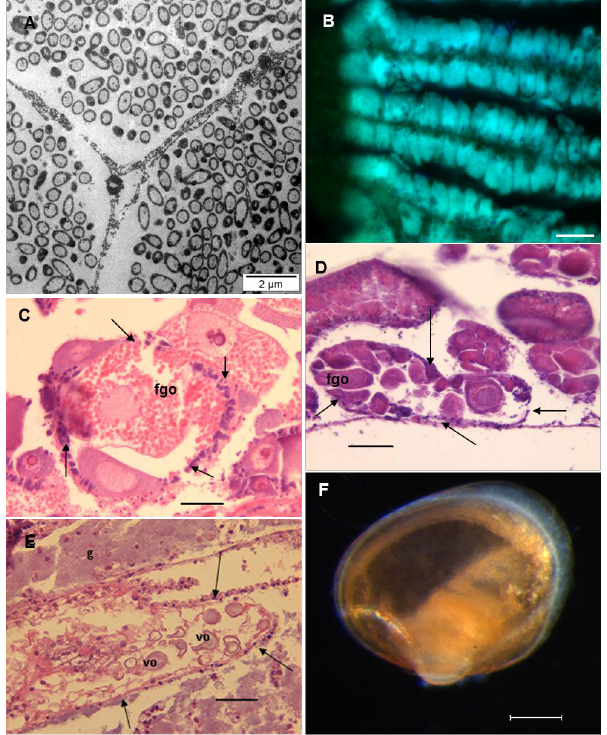
Figure 3: Fig. 3. (A) Detail of sulfur-oxidizing symbionts associated with gill filaments of Thyasira sp. Regab (Thyasiridae) under the TEM. (B) Fluorescence in situ hybridization using a symbiont-specific probe on a cross section through 3 gill filaments of Myrtea spinifera (Lucinidae) showing the dense populations of bacteria in the lat- eral zone. Scale bar=50µm. (C–E) Histological sections of fe- male gonads stained with hematoxylin-eosin. Scales bars are 50µm. (C) Detail of an acinus (arrows delimiting) encompassing a large lecithotrophic oocyte (fgo: fully grown oocytes of ∼ 150µm diam- eter) in Isorropodon bigoti (Vesicomyidae). (D) Detail of an acinus (arrows delimiting) encompassing smaller fully grown oocytes (fgo; ∼ 60µm diameter) in Idas modiolaeformis (Mytilidae) that has a planktotrophic larvae. (E) Detail of a gonad (arrows delimiting) en- compassing small vitellogenic oocytes (vo) ∼ 20 to 30µm diameter in Thyasira sp. nov. from the Guiness site (Thyasiridae, g for gills). (F) Early juvenile of Idas modiolaeformis , with prodissoconch II visible in orange and the surrounding young dissoconch in white. Notice the low number of gill filaments visible by transparency. Scale